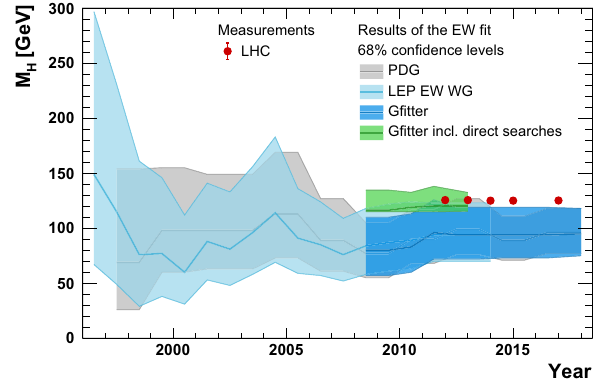
Fig. 2 Prediction of the Higgs boson mass versus year as obtained by various analysis groups using electroweak precision data (grey [6], light blue [5], dark blue [7]) and including direct search results (green [7]). The bands indicate the 68% confidence level. The direct M H measure- ments after the Higgs boson discovery are displayed by the red data points